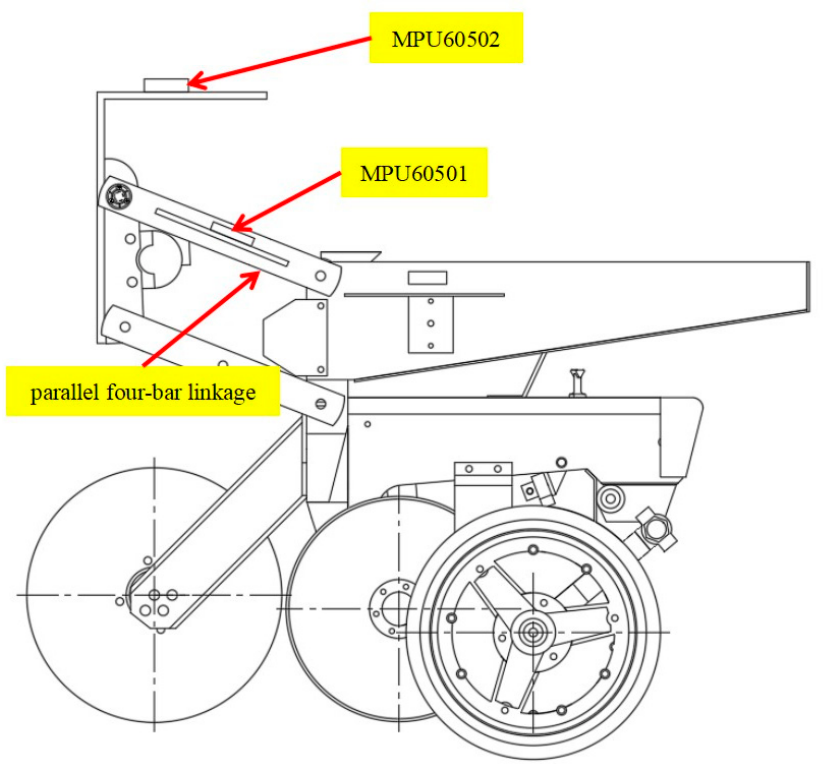
Figure 1. Two-dimensional structure diagram of the sowing monomer.